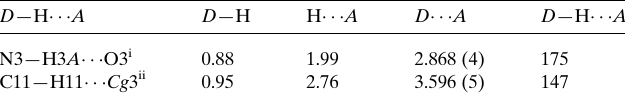
Table 1 Hydrogen-bond geometry (A˚ , (cid:2) ).